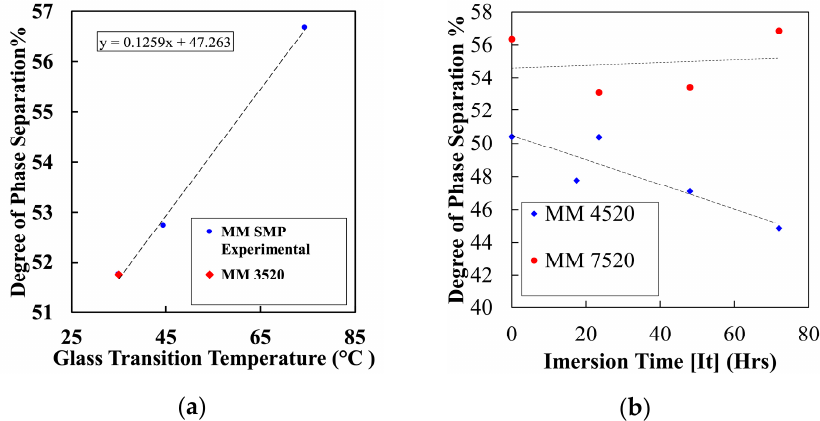
Figure 6. ( a ) Degree of phase separation with respect to different SMPU series (MM3520, MM4520 and MM7520) and ( b ) change in the degree of phase separation with respect to moisture absorption for MM4520 and MM7520.